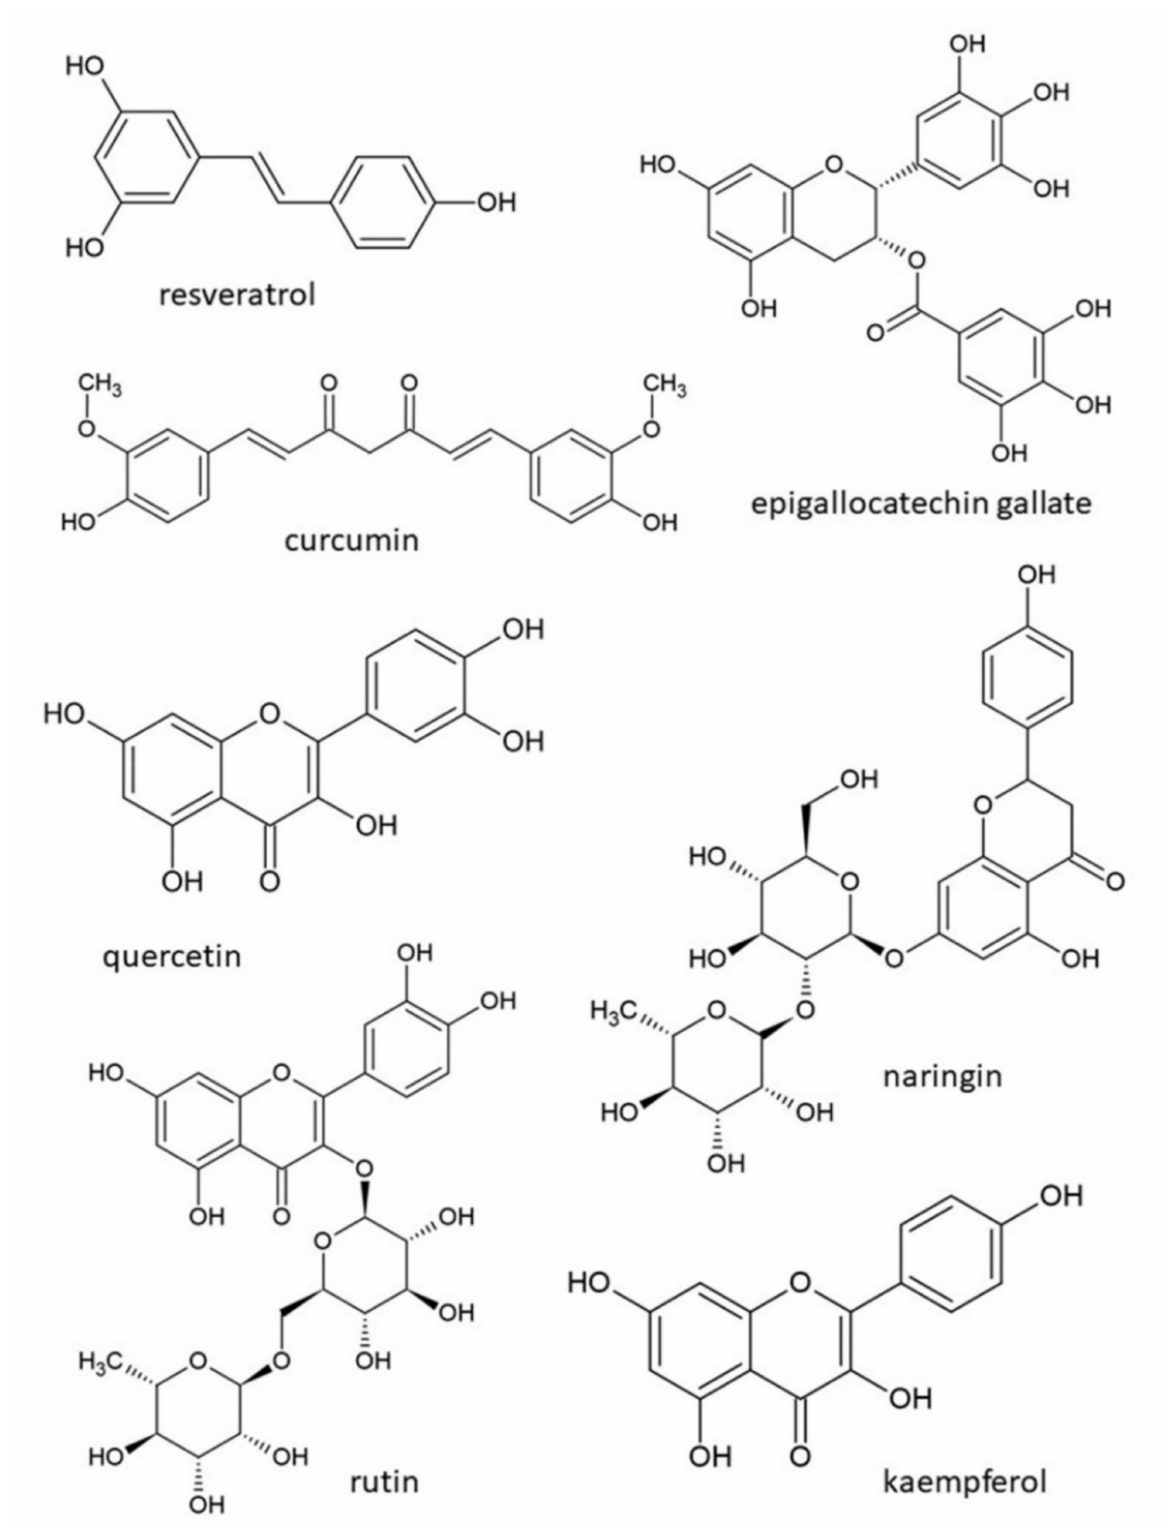
Figure 3. Chemical structures of selected natural